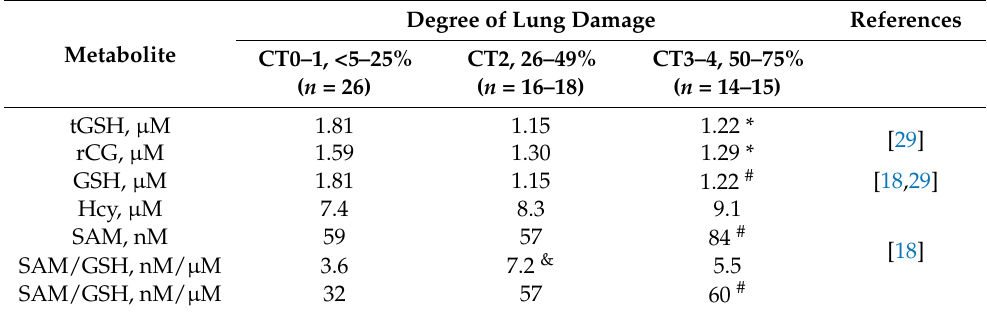
Metabolite Table 2. Sulphur metabolites in COVID-19 patients stratified by a degree of lung damage.